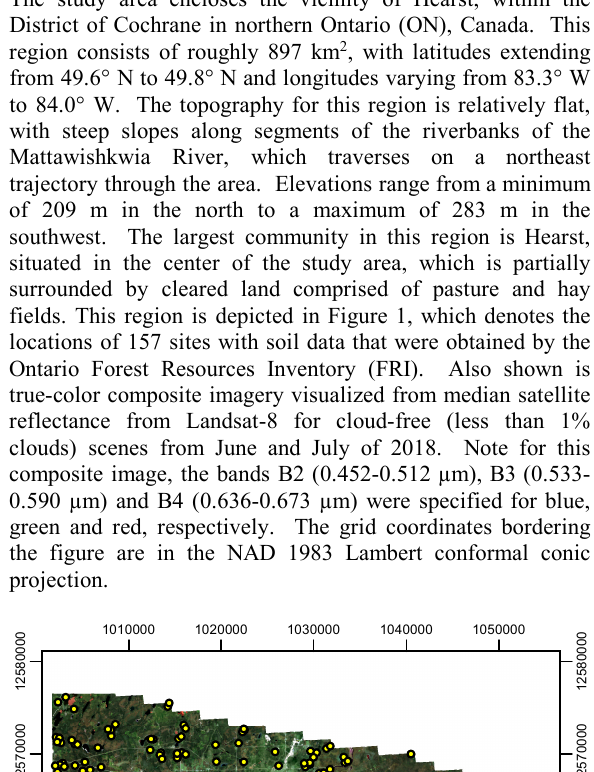
Surface reflectance bands; seasons were Winter (January, February, March), May, Summer (June, July) & Autumn (Sep. 10 - Oct. 10). For May & Autumn, median surface reflectance was obtained for same period over 5 years